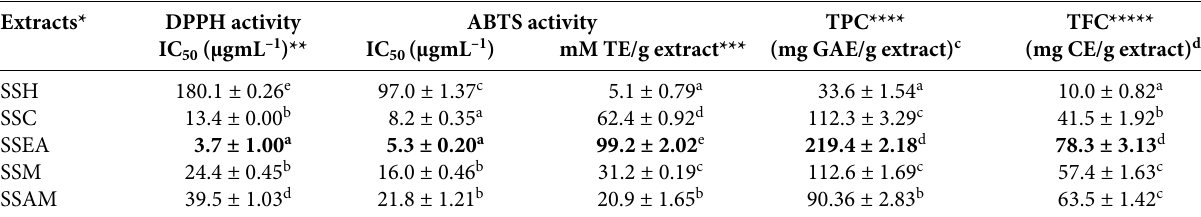
Table 2. Antioxidant activities, total phenolic and flavonoid contents of various extracts from aerial parts S. subnuda Extracts* DPPH activity ABTS